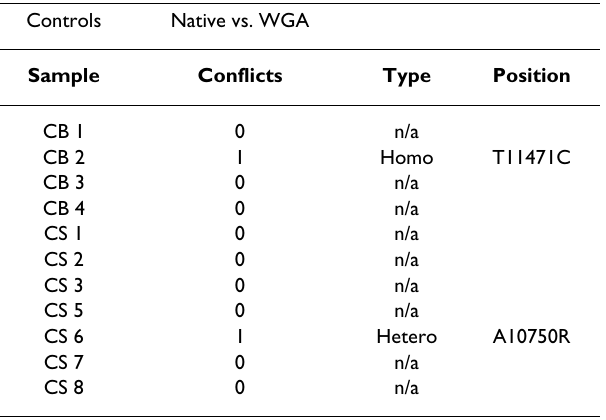
Table 2: Controls: native vs. WGA Controls